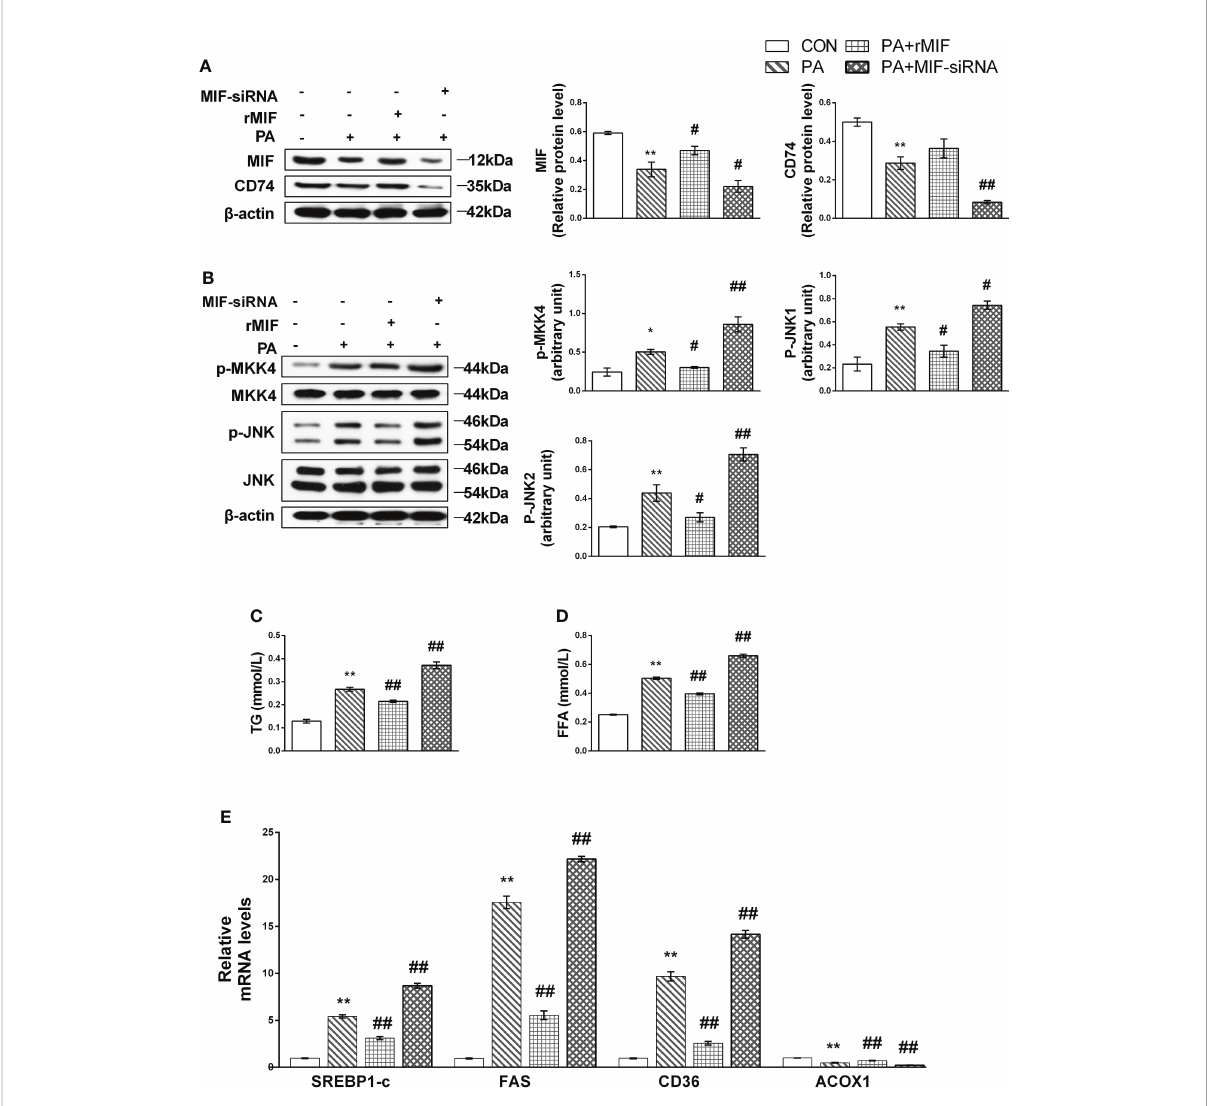
FIGURE 6 MIF inhibits MKK4/JNK and alleviated lipid accumulation in PA-treated HepG2 cells. HepG2 cells were cultured with 400 mmol/L PA for 24 h, and then exogenous rMIF 200 ng/ml was added for 24 h or transfected with MIF siRNA; protein expression levels of MIF and CD74 (A) , phosphorylated, and total MKK4 and JNK (B) were detected by Western blot analysis ( n = 3 per group). Quanti fi cation of immunoblots is shown in the graphs below the blots. mRNA expression of FAS, SREBP-1c, CD36, and ACOX1 were detected by RT-PCR (C, D) ( n = 5 per group). TG and FFA contents were measured (E) . ( n = 3 per group) M ± SEM. * P < 0.05 versus Con; ** P < 0.01 versus Con; # P < 0.05 versus PA; ## P < 0.01 versus